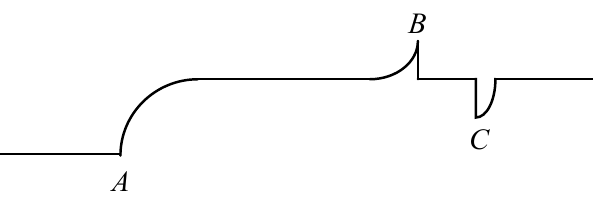
Figure 2. Illustration of the edge point and noise point.